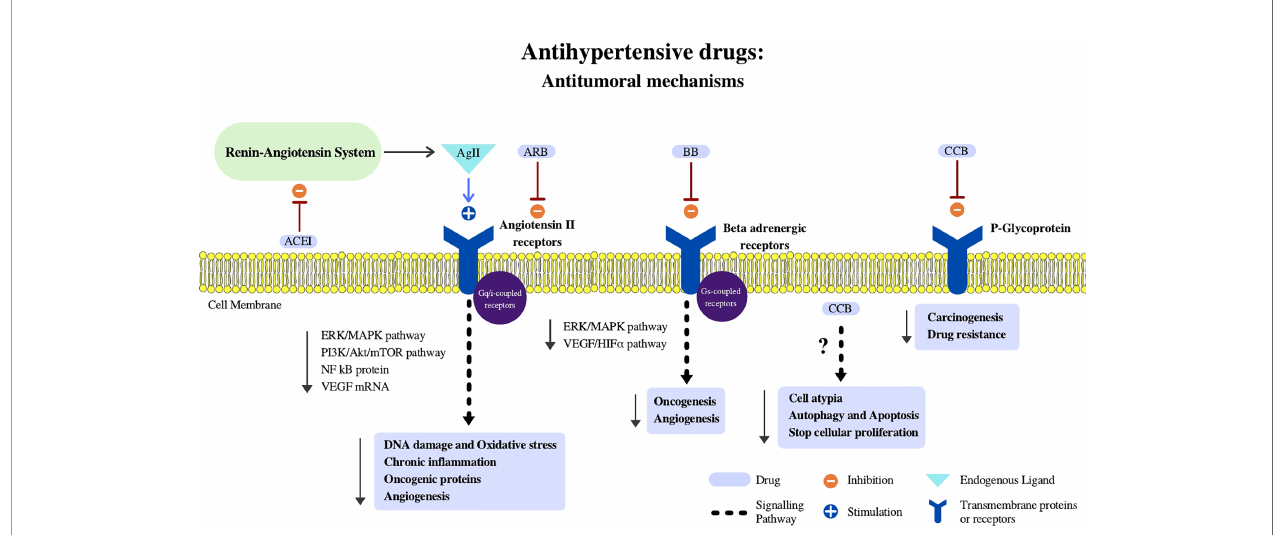
FIGURE 2 | Antihypertensive drugs: Antitumoral mechanisms. In this fi gure we summarize potential mechanisms in which antihypertensive drugs may aid oncologic therapies throughout different cellular effects schematized in the fi gure. Ag II, Angiotensin II; Epi, Epinephrine; NFkB, Nuclear factor kappa B; VEGF, Vascular Endothelial Growth Factor; HIF a , Hipoxia Induced Factor Alpha; ARB, Angiotensin II Receptor Blockers; BB, Beta Blockers; CCB, Calcium Channel